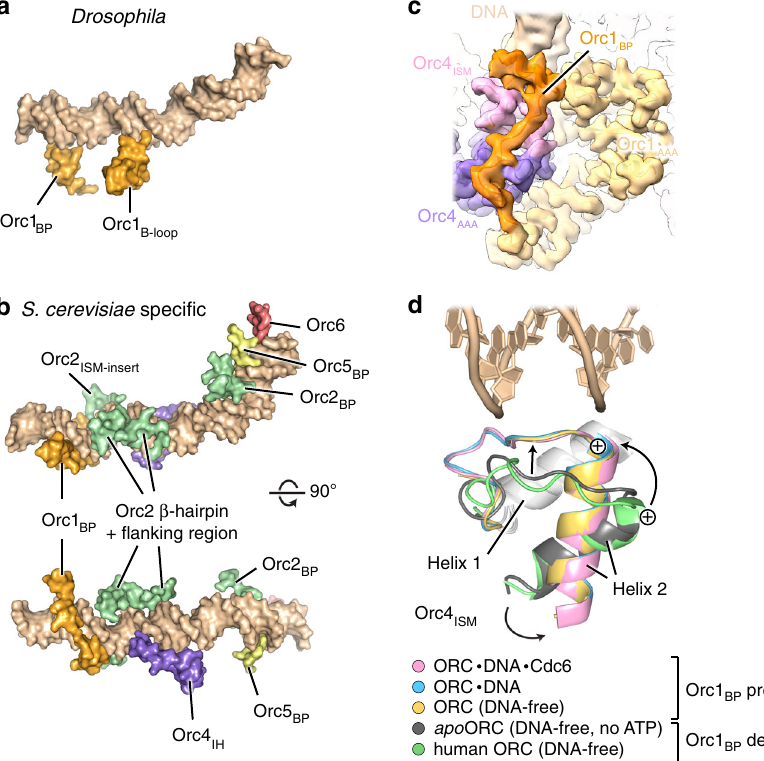
Fig. 5 Comparison of S. cerevisiae and Drosophila ORC – DNA contacts. a The B-loop of Orc1 engages DNA in Drosophila but not in budding yeast ORC, while interactions between the Orc1-BP and DNA differ in both systems. DNA binding elements shared with S. cerevisiae ORC are not shown. b S. cerevisiae ORC uses numerous additional regions to associate with DNA in the cryo-EM structure of the DNA-bound budding yeast initiator (PDB 5zr1 20 ). A subset of these are yeast-speci fi c insertions in ORC subunits (e.g., Orc2 ISM-insert , Orc4 IH ), while others are fl exible in Dm ORC·DNA and/or Dm ORC·DNA·Cdc6 (i.e., Orc2 BP , Orc5 BP , Orc6 TFIIB ). Only duplex-binding regions unique to the S. cerevisiae structure are shown. Note also that the basic patch of S. cerevisiae Orc1 tracks in the DNA minor groove. c In Drosophila Orc1, the basic patch packs against the ISM of Orc4 and N-terminally folds into a helix that contacts the phosphodiester backbone but does not engage the minor groove. Unsharpened EM map density is shown. d Docking of the Orc1-basic patch reorients the second Orc4-ISM helix, priming it for DNA binding. The Orc4-ISMs from Dm ORC structures determined in this study (all containing the Orc1-basic patch) are superposed onto the Orc4-ISMs from the apo - Dm ORC and human Orc1/4/5 crystal structures (PDBs 4gxc 16 and 5uj7 17 ; both determined in the absence of the Orc1-basic patch). The repositioning of the positive ISM helix 2 dipole is indicated. BP, basic patch; IH, insertion helix; ISM, initiator- speci fi c